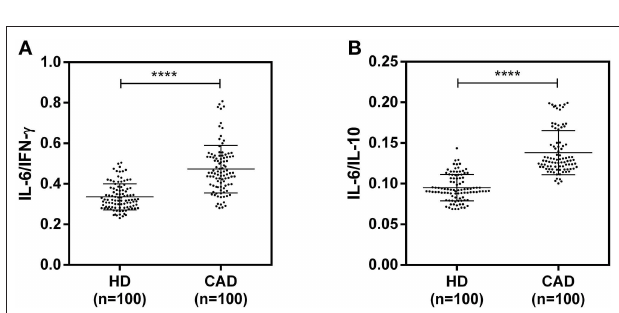
FIGURE 6 | Chronic inflammation status in CAD patients (A,B) . Ratios of IL6/IFN- γ and IL6/IL10 in CAD patients were calculated and used as a reference for the status of chronic inflammation. Mann-Whitney U test was used for comparison of values between groups. Four asterisks (****) indicate a p -value of <